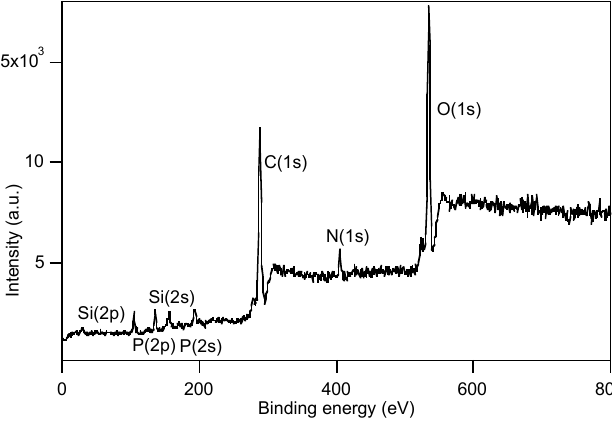
Figure 6. XPS survey spectrum for p(MPC -co- PTMSi5) ( ϕ = 70°) .